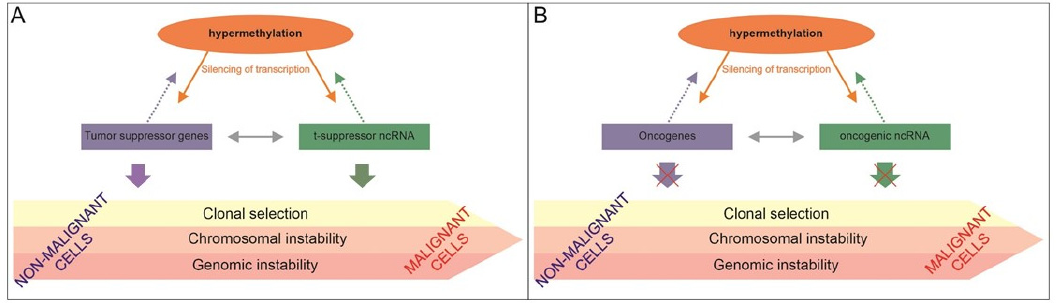
Figure 4. Simplified illustration of genetic and epigenetic interplay in ovary carcinogenesis. This complex process is reduced on the role of tumor suppressors (panel ( A )) and oncogenes (panel ( B )) in malignant transformation. Both panels indicate the effect of hypermethylation on transcription of tumor suppressor genes ( A ) and oncogenes ( B ) along with the involvement of non-coding RNAs. These may regulate tumor suppressing or oncogenic effects directly or in interaction with methylation. There are mutual regulations between non-coding RNAs and methylation status (full orange arrows) or the effect of non-coding RNAs on methylation status (dotted arrows), most likely via expression of DNA methyltrans- ferases.